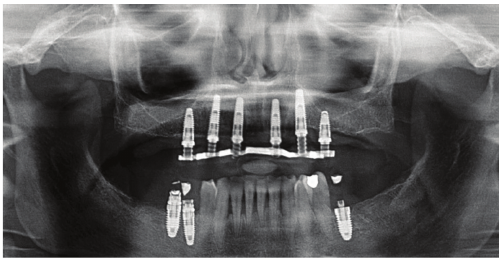
Figure 6: Final restoration with zirconia ceramic screw-retained prosthesis.